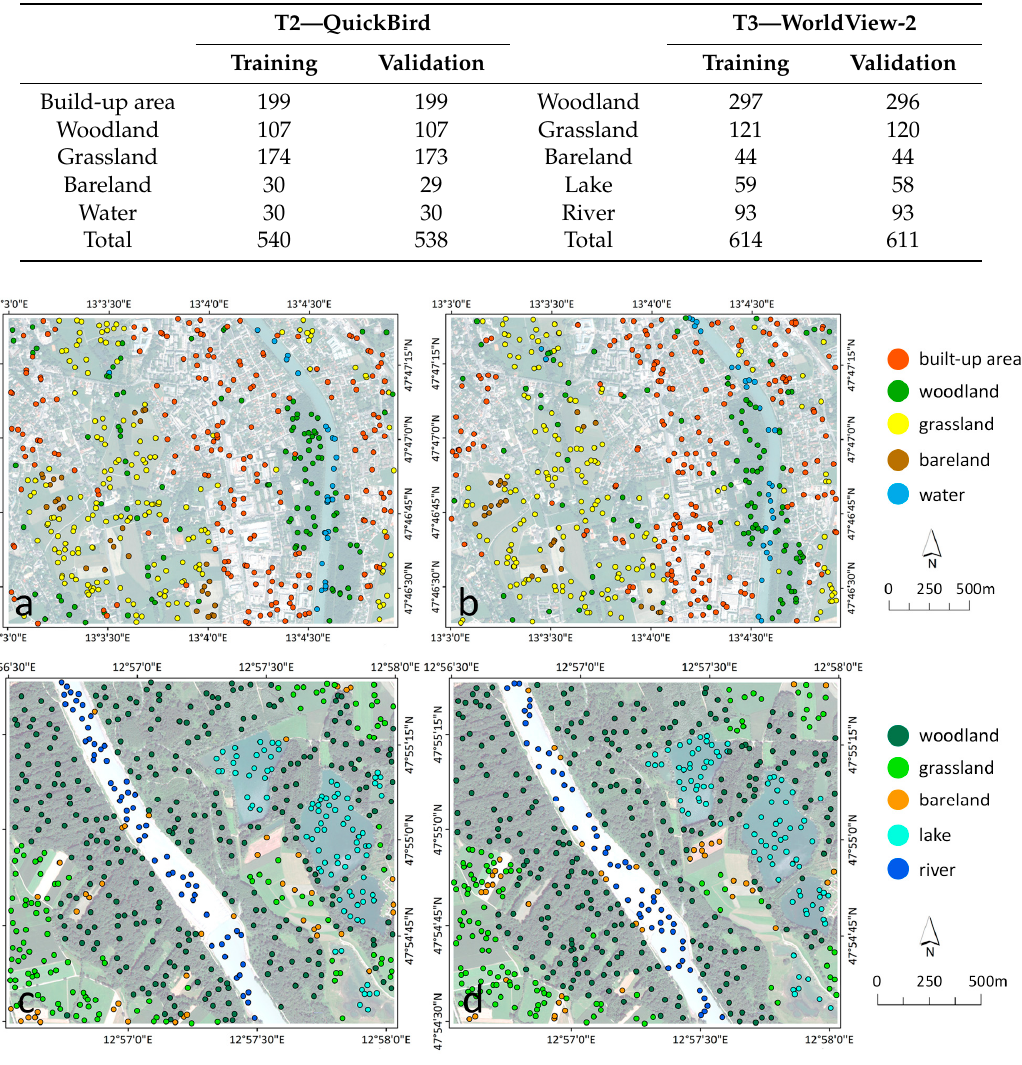
Figure 3. Spatial distribution of samples used for classification: ( a ) training and ( b ) validation samples for QuickBird and ( c ) training and ( d ) validation samples for WorldView-2 datasets.